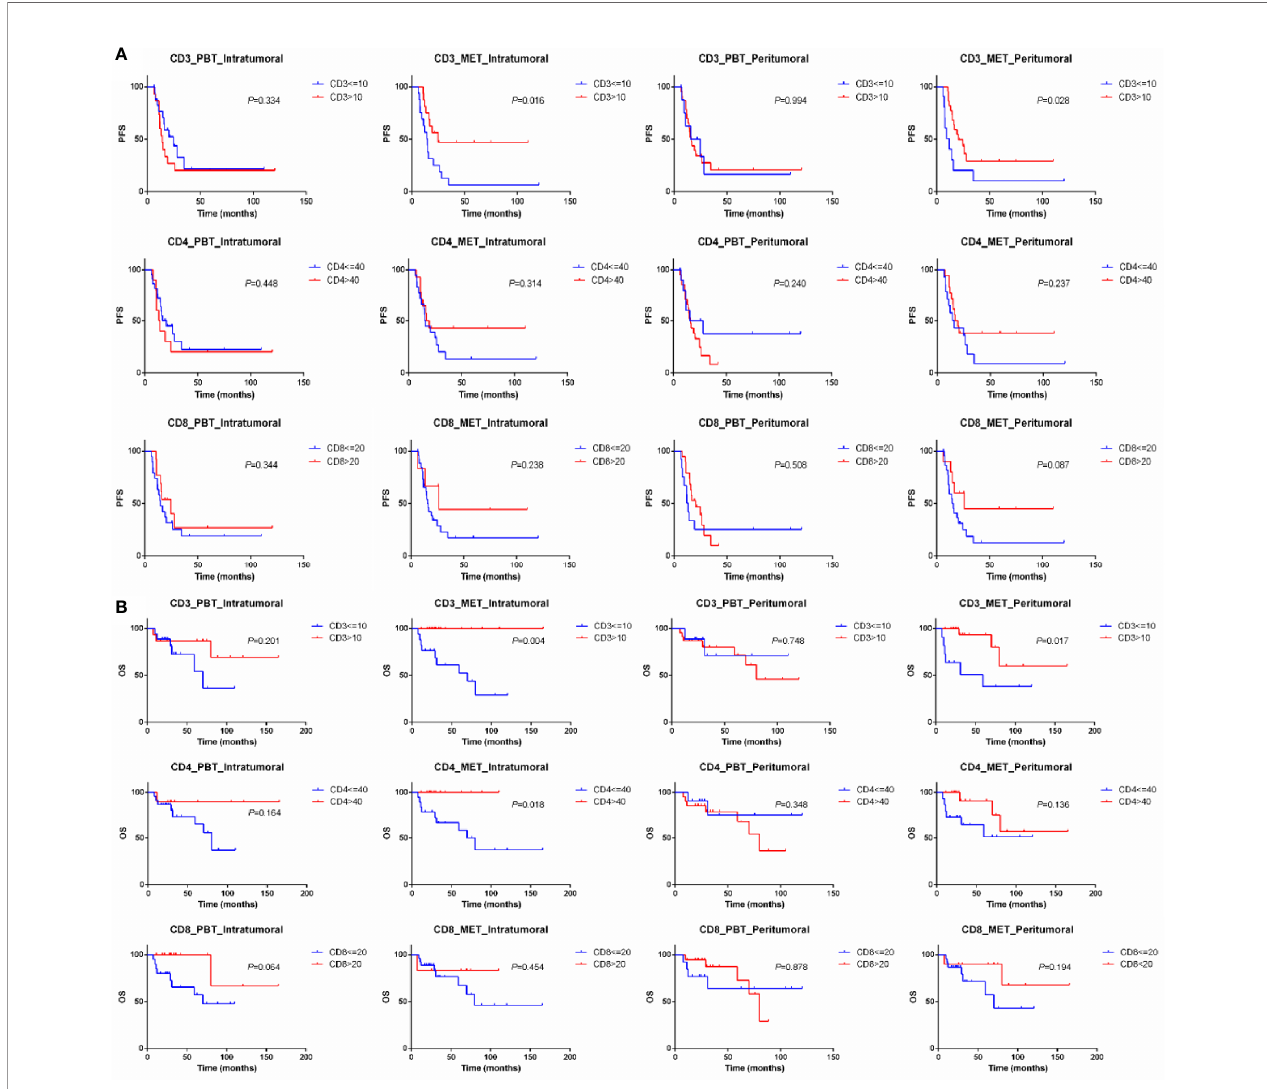
FIGURE 5 | Kaplan – Meier curve for PFS (A) and OS (B) of oligometastatic breast cancer patients strati fi ed by the expression of CD3, CD4 and CD8. PBT, primary breast tissue; MET, oligometastatic